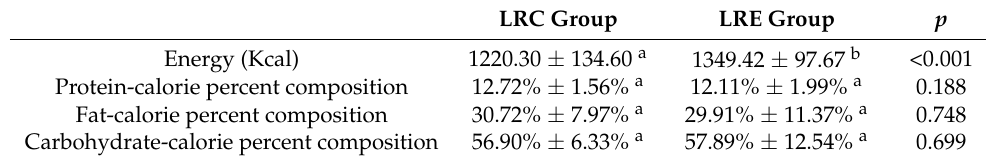
Values are means ± SD. The p values are obtained by t -test. Values without a common superscript letter in a row are significantly different. LRC, centenarians in the longevous region; LRE, elderly people aged 60–70 years in the longevous region.